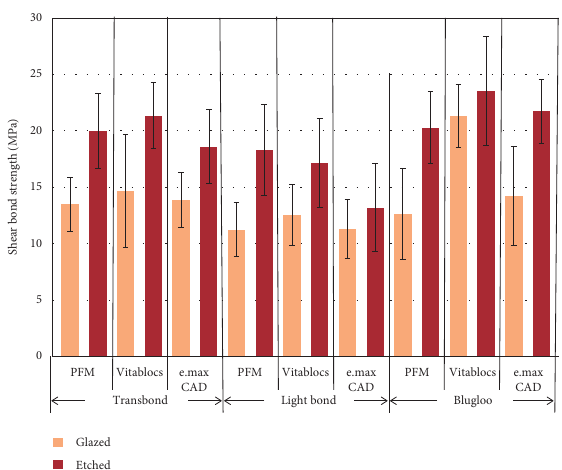
Figure 2: Load applied through adhesive/ceramic interface at 0.5mm/min crosshead